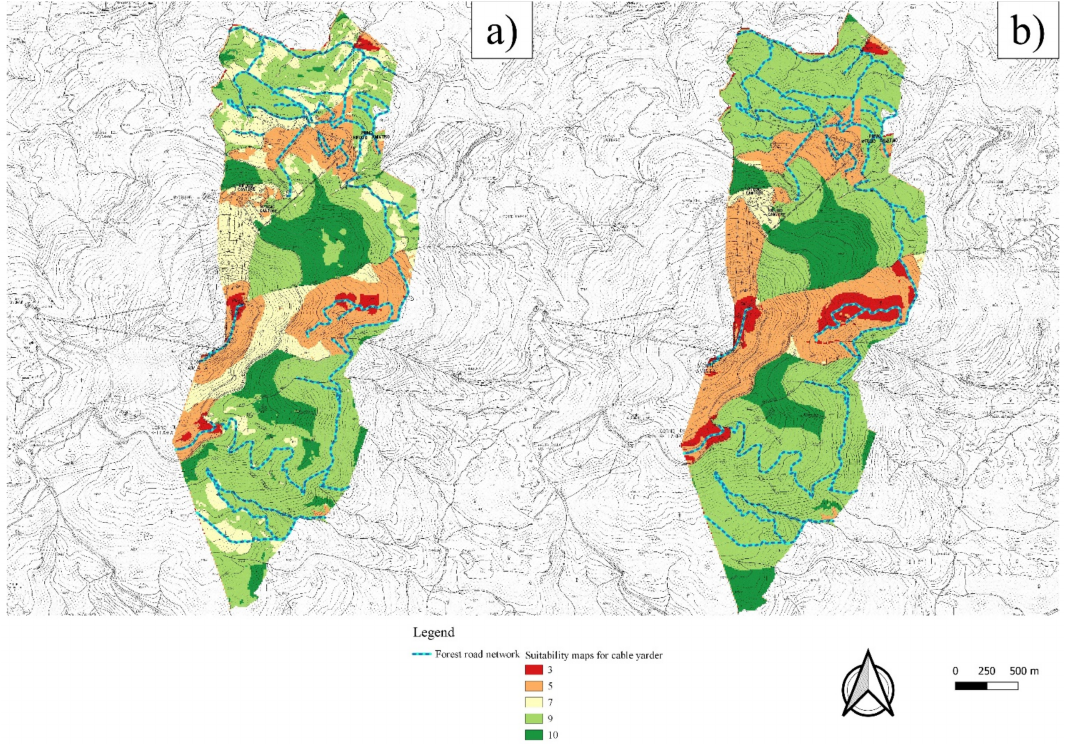
Figure 4. ( a ) Suitability map for forwarder, derived from the analysis with RTS input data. ( b ) Suitability map for forwarder, derived from the analysis with OS input